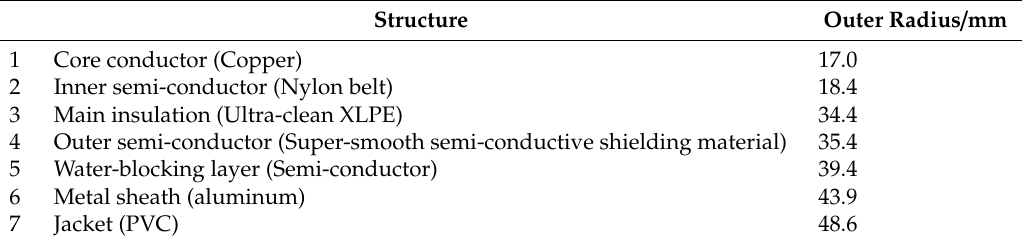
Figure 6. The configuration of a horizontal laid HV (high voltage) cable system. Table 1. Parameters of cross-sectional structure of the HV cable.